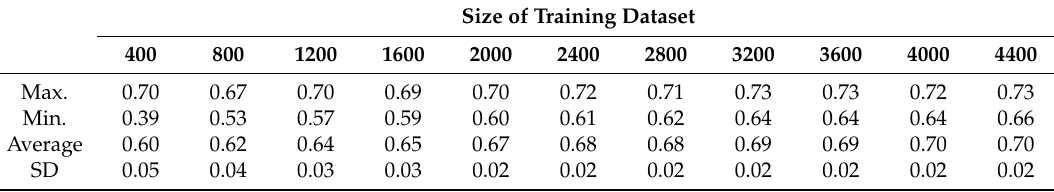
0.4 Figure 10. Model accuracy for spectral-yield displacement 𝑆 𝑎𝑦 with 20 building characteristics.